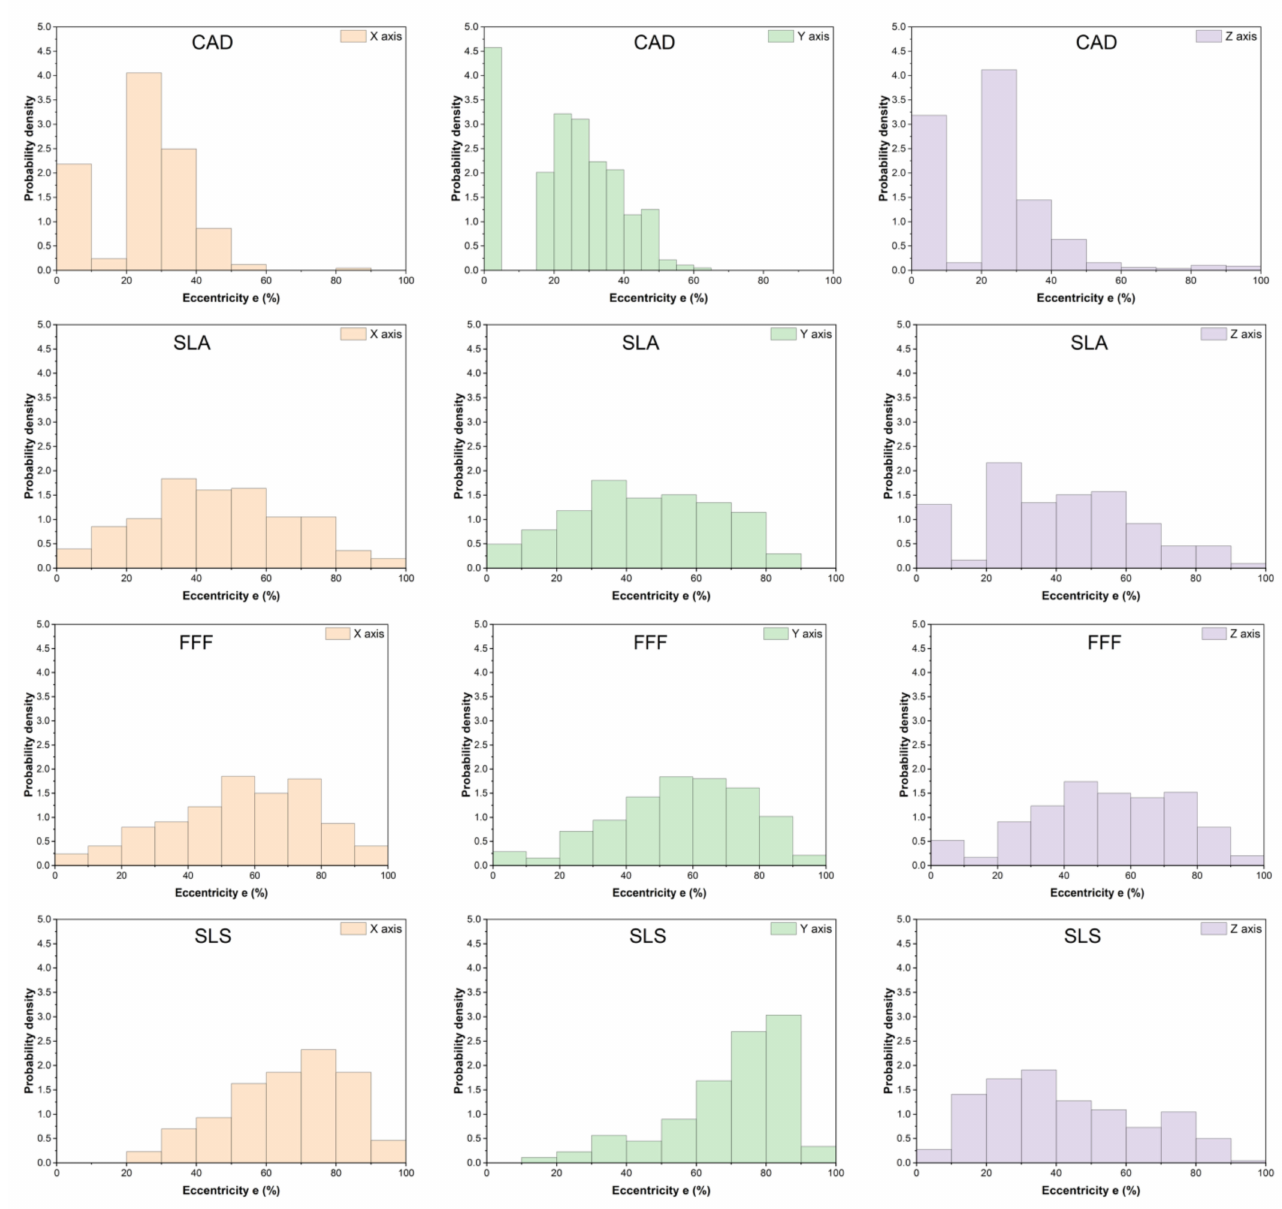
Figure 10. Eccentricity “e” of the cross-sections, sample 05 for CAD model and the three